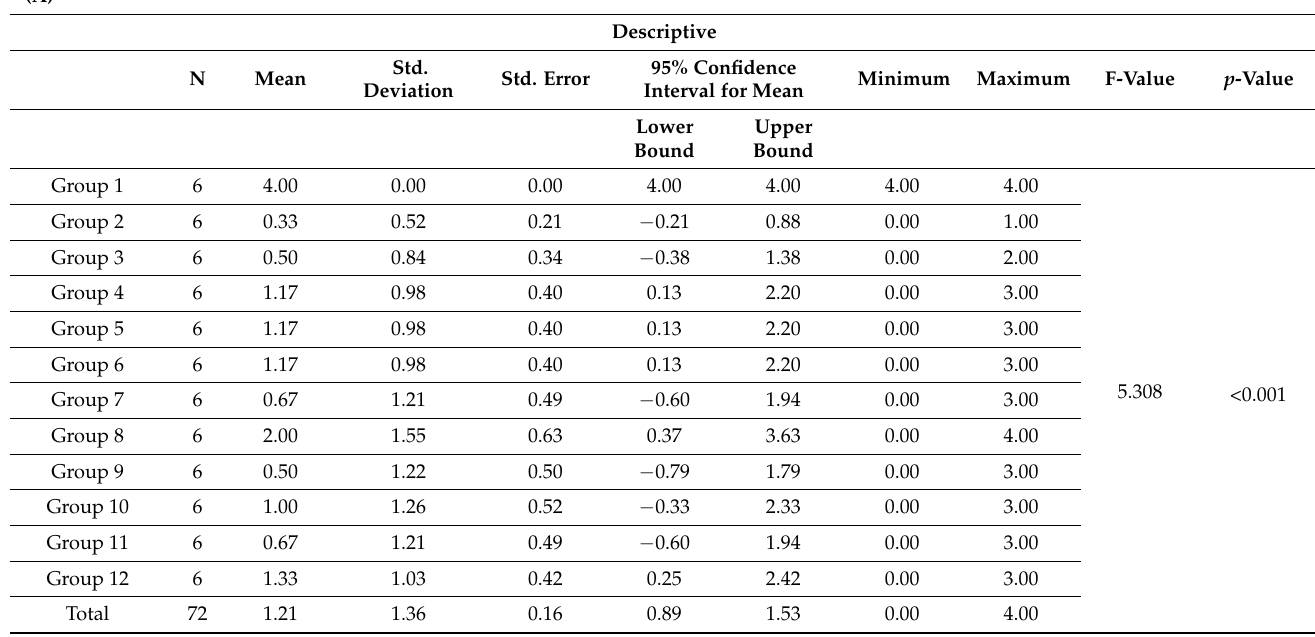
Figure 3: The control was compared to the other surface treatment modalities. The surface treatment of Group 8—Laser irradiation followed by the application of CPP-ACPF— had results comparable to those of the control samples, i.e., natural teeth. A post hoc test for multiple comparisons of groups was carried out, and it was observed that the surface treatment of 3.5 watts followed by CPP-ACPF resulted in values similar to those of the control. The other groups had significant deviations from that of the control (Table 1 (B)). Table 1 (B): With the application of the post hoc test, we concluded that there were significant differences between Group 1 and all other groups, except for Group 8. The difference between Group 1 and Group 8 was non-significant. All other groups had non- significant differences from each other. Table 1. (A): Comparison of mean values between the groups. (B): Post hoc test for multiple